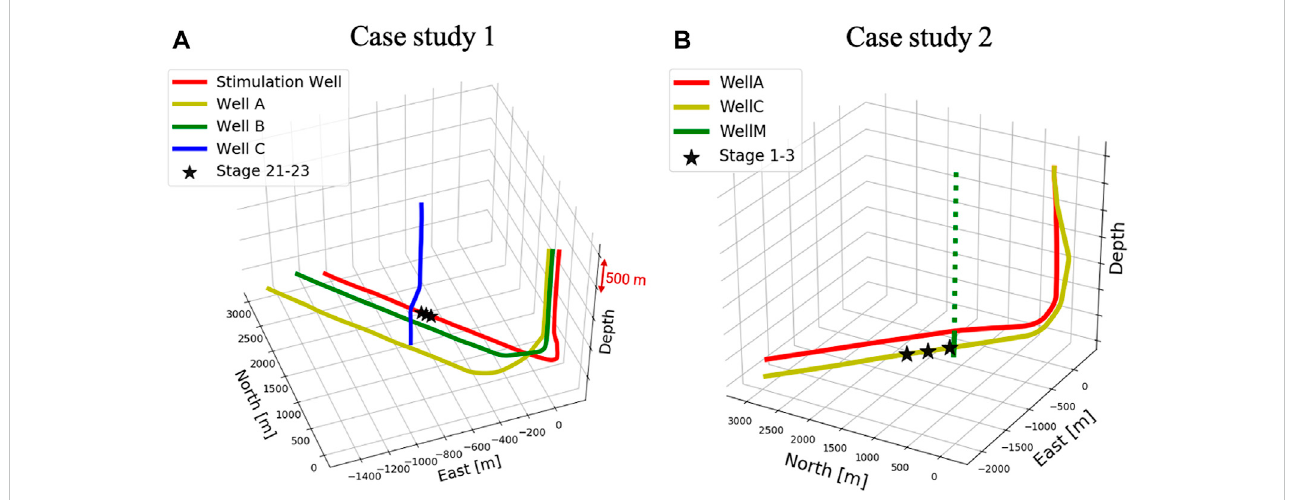
FIGURE 6 (A) Casestudy 1wellgeometry:Two fi bersarepermanentlyinstalledinhorizontalWell AandB,oneinvertical WellC.Starsindicate perforationlocations of three stages discussed in this paper. (B) Case study 2 has a similar well geometry. Two fi bers are permanently installed in horizontal Well A and C, one in vertical Well M.